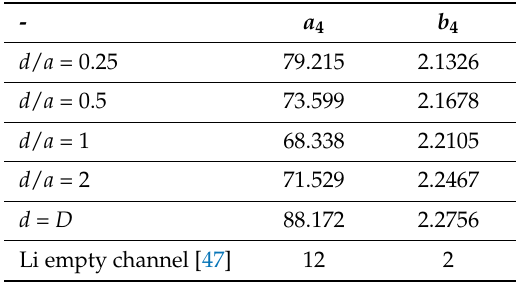
Table 3. The dimensionless power number function